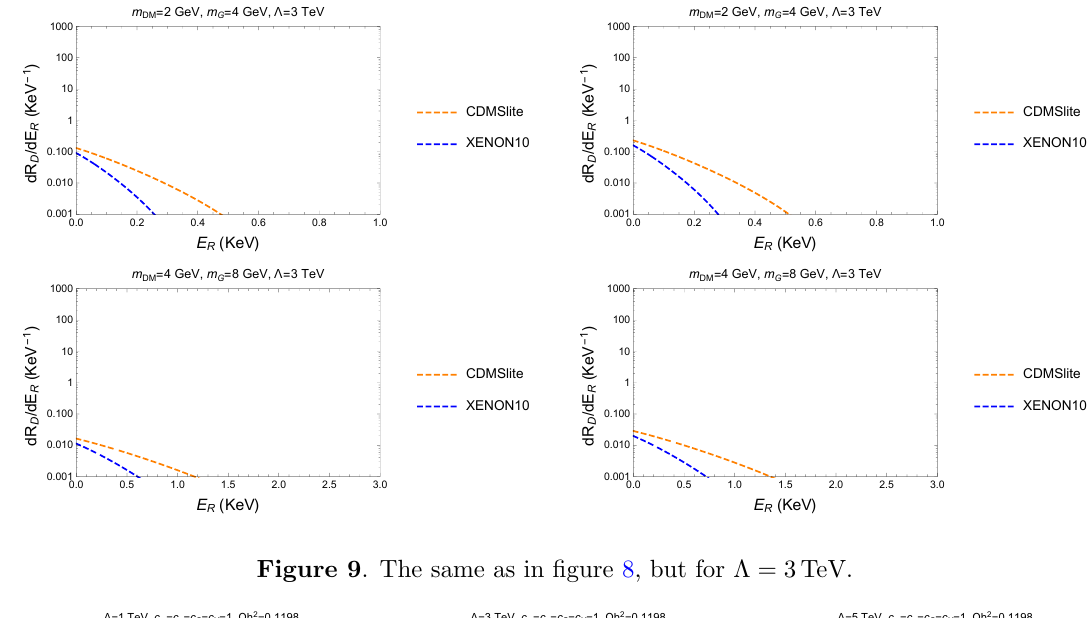
Figure 9 . The same as in (cid:12)gure 8, but for (cid:3) = 3 TeV.